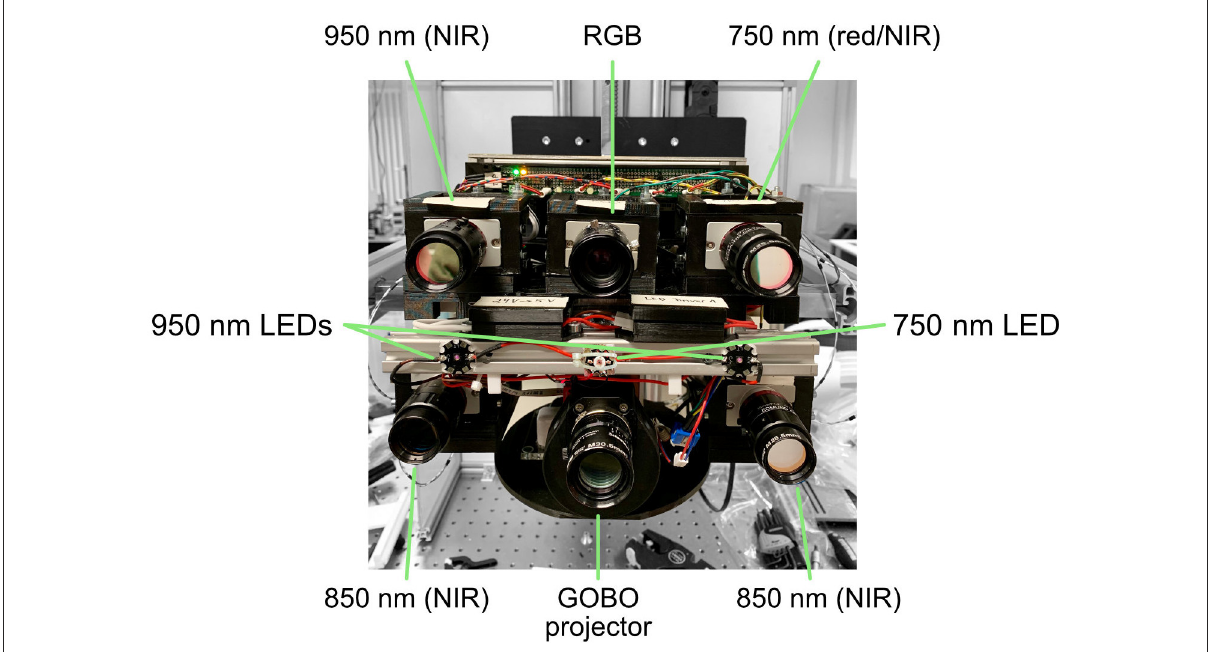
FIGURE1 Interior of the multimodal 3D camera system with annotations for key components described in the main body of the text.